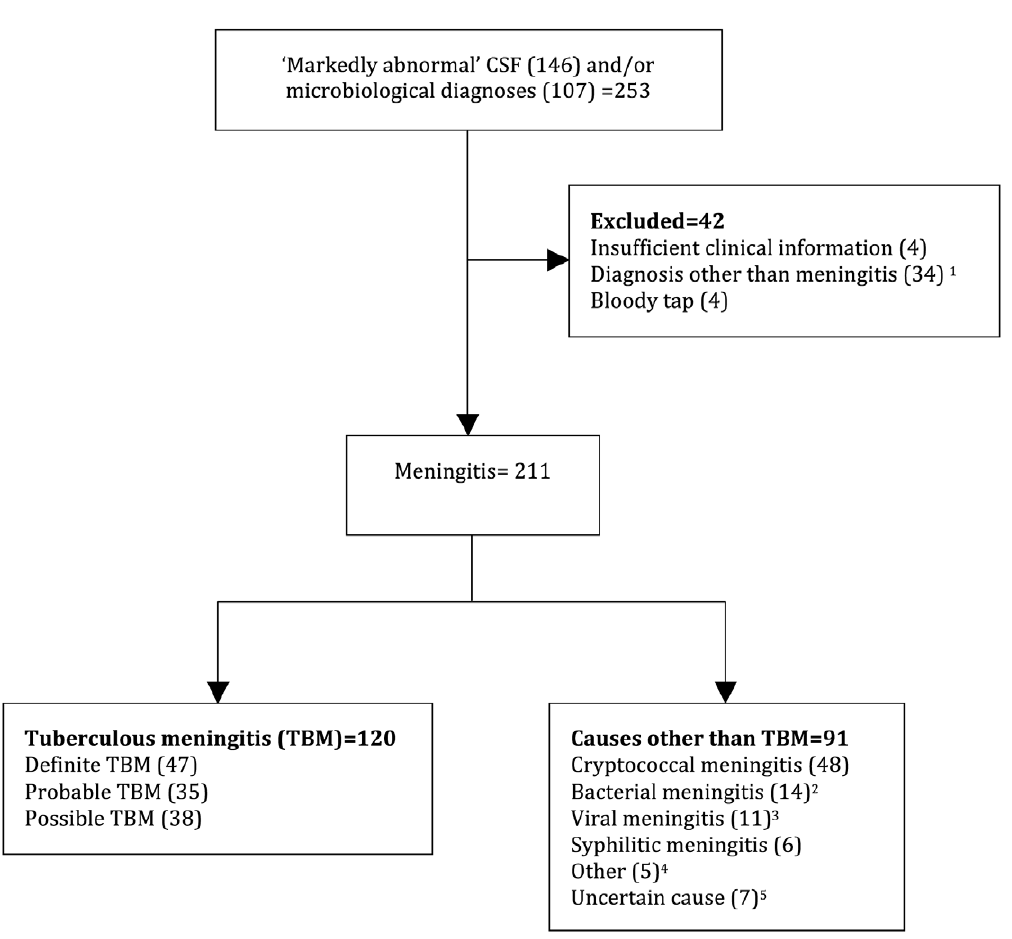
Figure 1. Flow diagram of differential diagnoses in patients with ‘markedly abnormal’ CSF and/or microbiological-confirmed meningitis. 1 Common alternative diagnoses include: hypoglycemia (n=9), intracranial bleed (n=7) and peripheral nerve disorders (n=6). 2 Including 5 patients with CSF culture-confirmed bacterial meningitis. Organisms isolated include: Streptococcus pneumonia (n=3), beta-hemolytic Streptococcus (n=1), Neisseria meningitides (n=1). 3 Including 1 patient with positive CSF polymerase chain reaction for both cytomegalovirus and herpes simplex-1 virus. 4 Other causes of meningitis include: Acute HIV infection (n=1), Toxoplasma gondii meningoencephalitis (n=1), disseminated Burkitt’s lymphoma (n=1), disseminated large B-cell lymphoma (n=1), chronic resolving TBM immune reconstitution inflammatory syndrome (n=1). 5 Including patients with the following differential diagnoses: 1) TBM with tuberculoma or toxoplasmosis (n=1); 2) partially treated bacterial meningitis, viral meningitis or TBM (n=3); and 3) viral meningitis or TBM (n=3). CSF, cerebrospinal fluid.